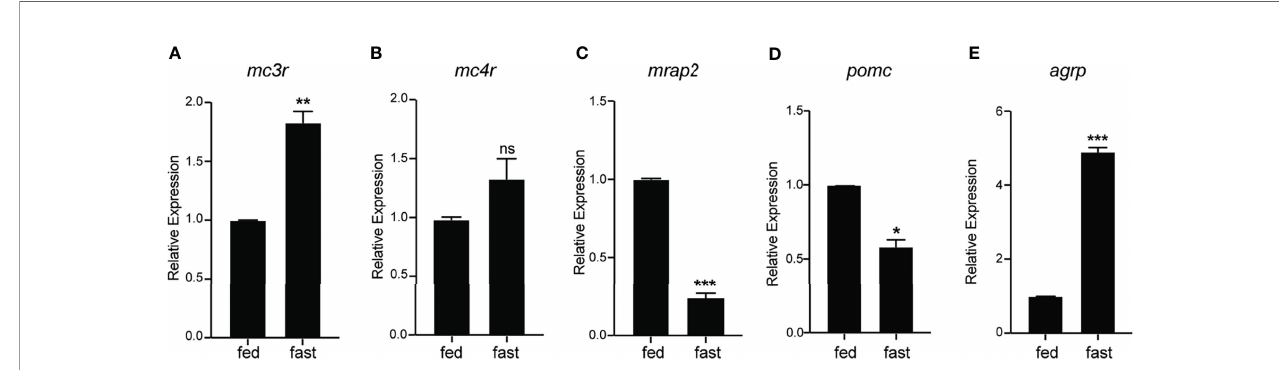
FIGURE 8 | Fasting induced expression dynamics of mc3r , mc4r , mrap2 , agrp , and pomc in the axolotl hypothalamus. Juvenile axolotls were fasted for 3 weeks and the expression levels of (A) mc3r , (B) mc4r , (C) mrap2 , (D) pomc , and (E) agrp in the hypothalamus were analyzed by qRT-PCR. Data are analyzed by two- tailed t-test compared with the normal feeding group, graphs are shown as mean ± SEM. *P < 0.05, **P < 0.01; ***P < 0.001; ns, not signi